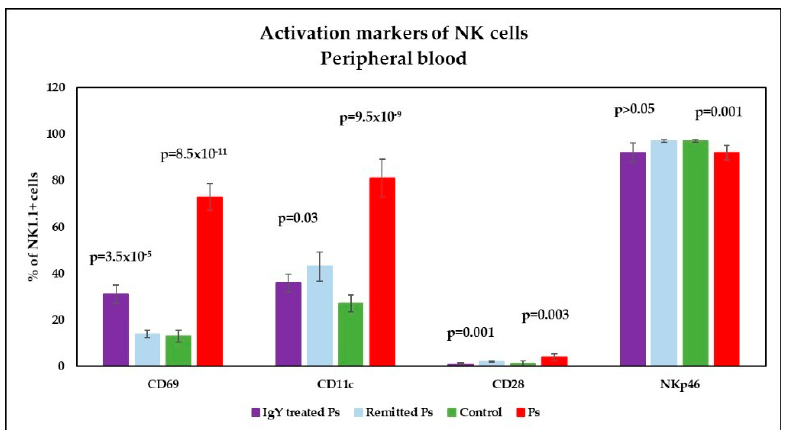
Figure 9. Expression of activation markers on NK cells in peripheral blood. Expression of CD69, CD11c, CD28 and NKp46 levels on NK1.1 + cells for IgY-treated Ps group ( n = 12) (31 ± 4; 36 ± 3.8; 1 ± 0.5; 92 ± 4.2) as compared to naturally remitted Ps group ( n = 8) (14 ± 1.6; 43 ± 6.4; 2 ± 0.3; 97 ± 0.6), control group ( n = 8) (13 ± 2.6; 27 ± 3.7; 1.2 ± 1.2; 97 ± 0.5) and Ps group ( n = 8) (73 ± 5.7; 81 ± 8.1; 4 ± 1.5; 92 ± 3.2). The results (% of NK1.1 + cells) are presented as mean ± SD; n = number of mice).